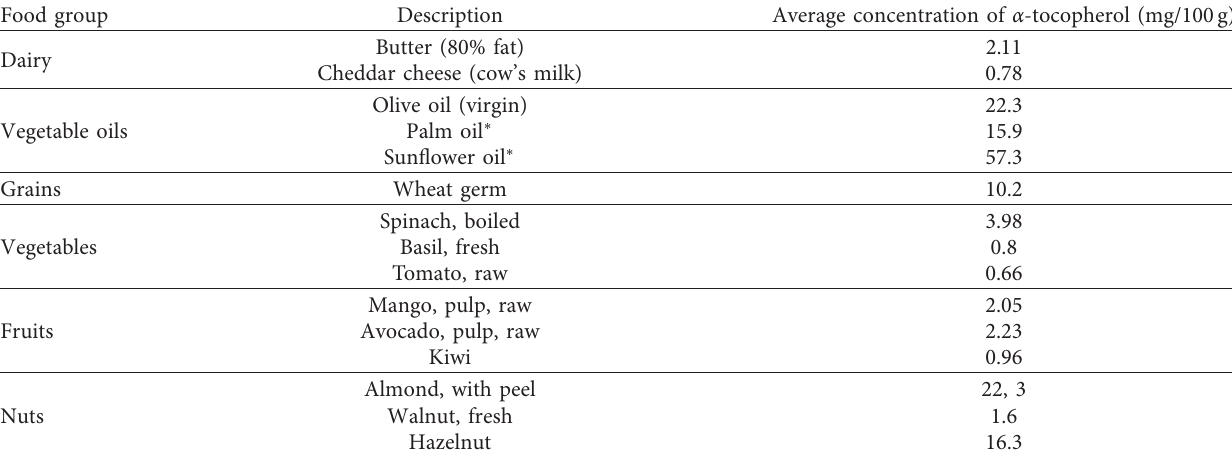
Table 1: Natural dietary sources of vitamin E and average content (mg/100 mg) according to ANSES-Ciqual food composition table. Food